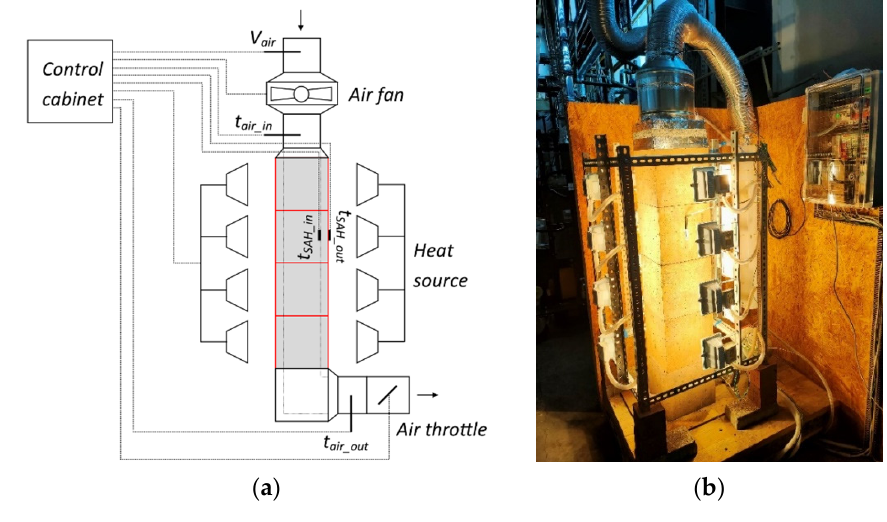
Figure 3. The experimental rig: the scheme ( a ) and the general view ( b ).